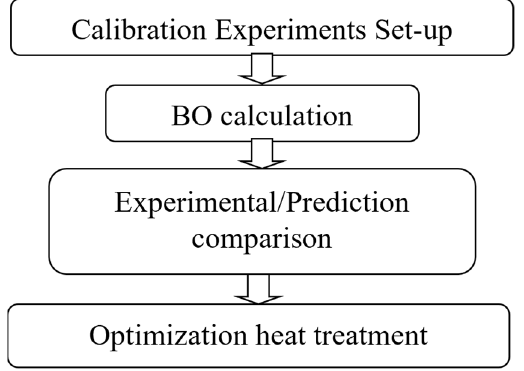
Figure 4. Flow chart of the model optimization and experimental verification.